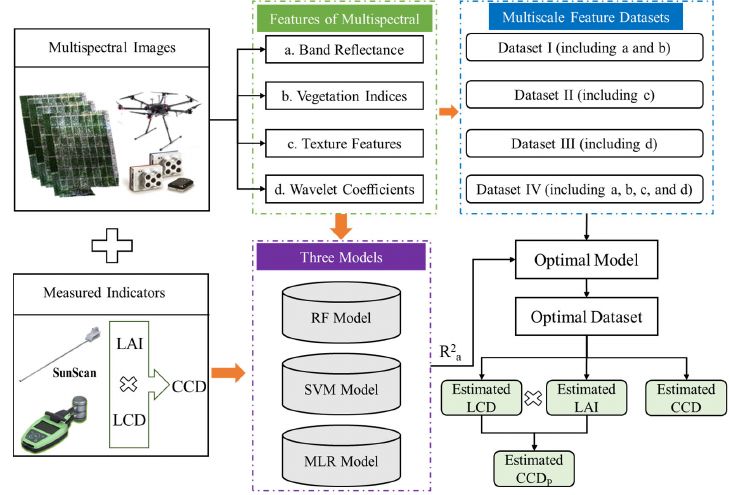
Figure 3. The flowchart of this study. Note: RF represents the random forest, SVM represents the Support Vector Machine, and MLR represents the Multivariable Linear Regression.